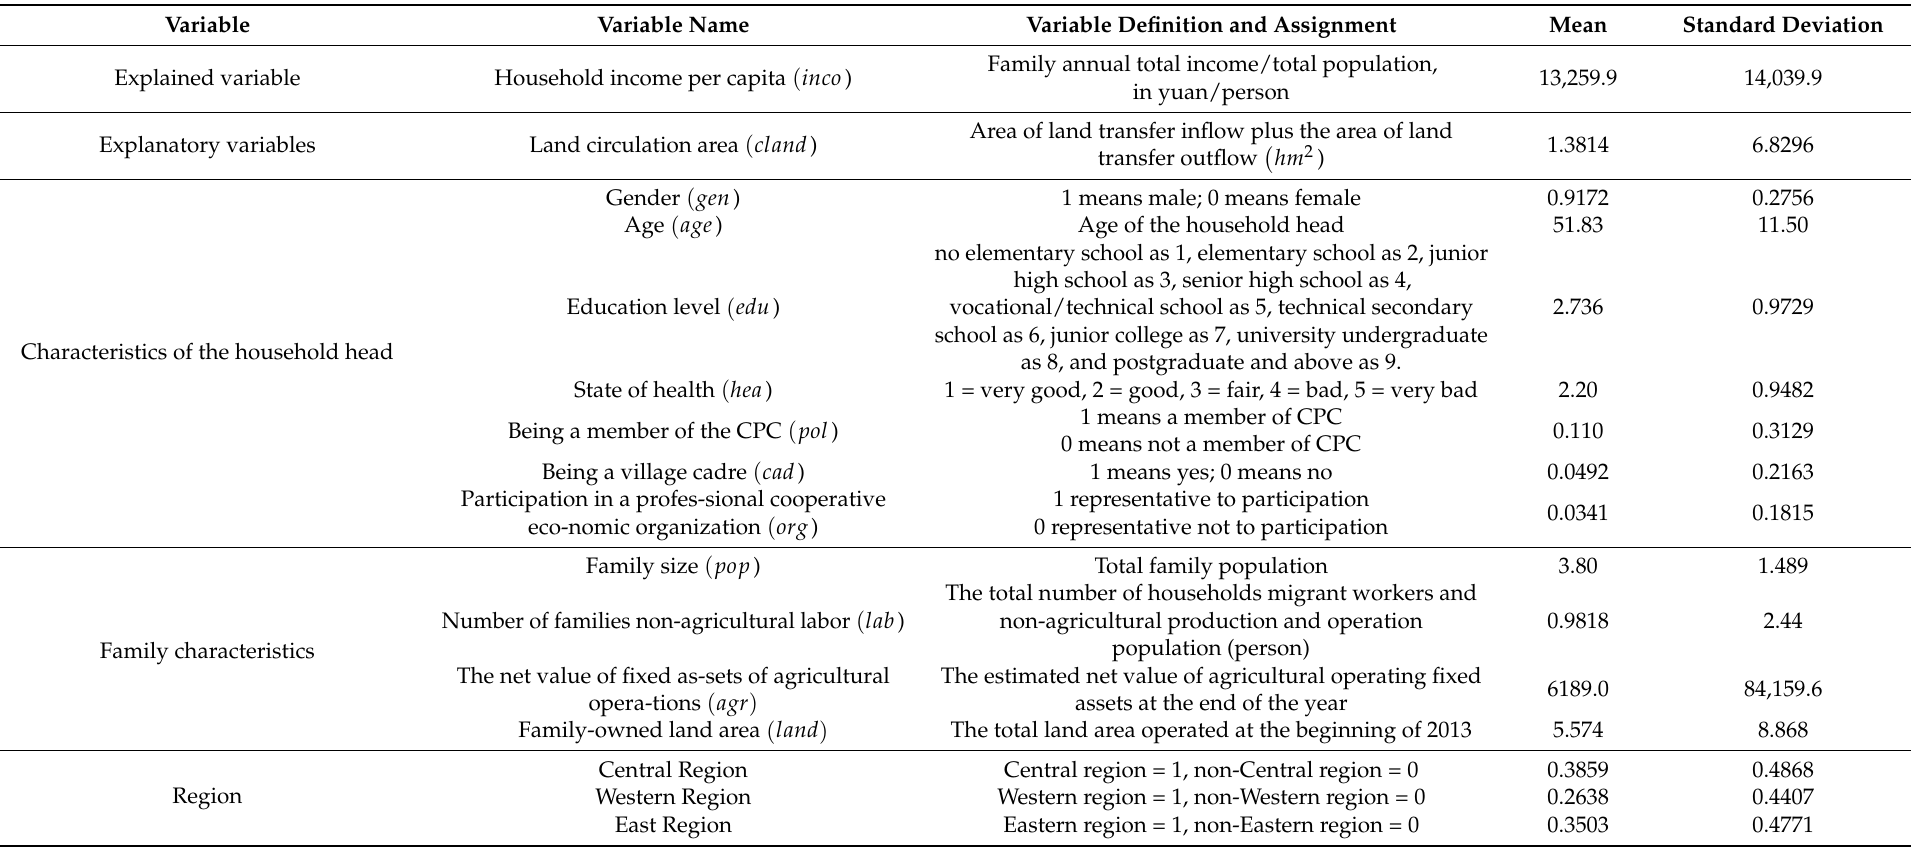
Table 1. Definitions of variables and descriptive